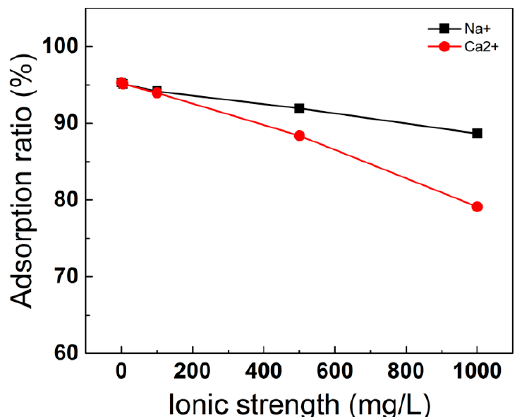
Figure 8. Effect of ionic strength on the adsorption of ionic liquid ([Bmim][BF 4 ]) onto ion-exchange resin (Amberlite IR 120Na).